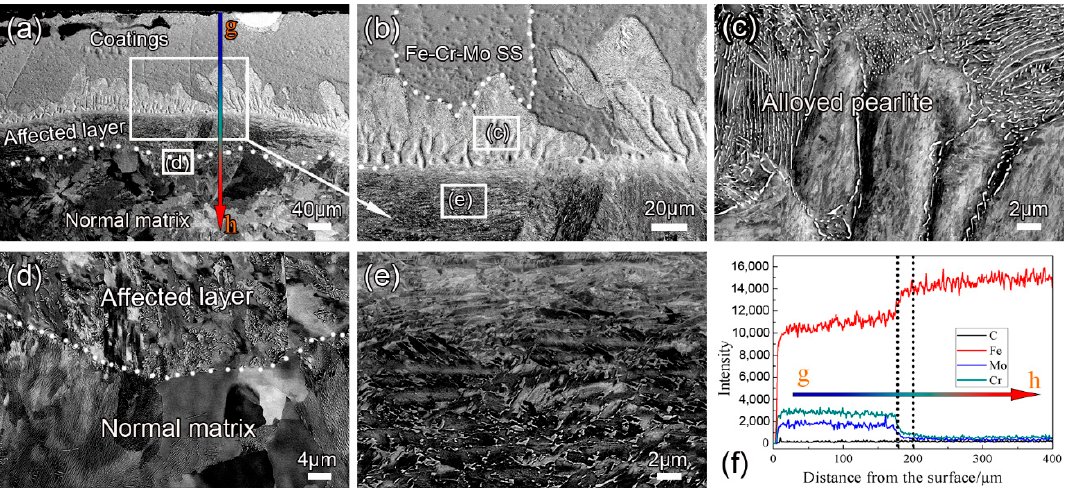
Figure 2. Backscattering electron imaging (BSEI) images and energy dispersive spectrometry (EDS) patterns of the CrMo-6 sample: ( a ) cross-sectional view showing the coating; ( b ) and ( d ) partial enlarged view of the corresponding part in ( a ); ( c ) and ( e ) are enlarged views of the white boxes in ( b ); ( f ) EDS line scanning spectra.